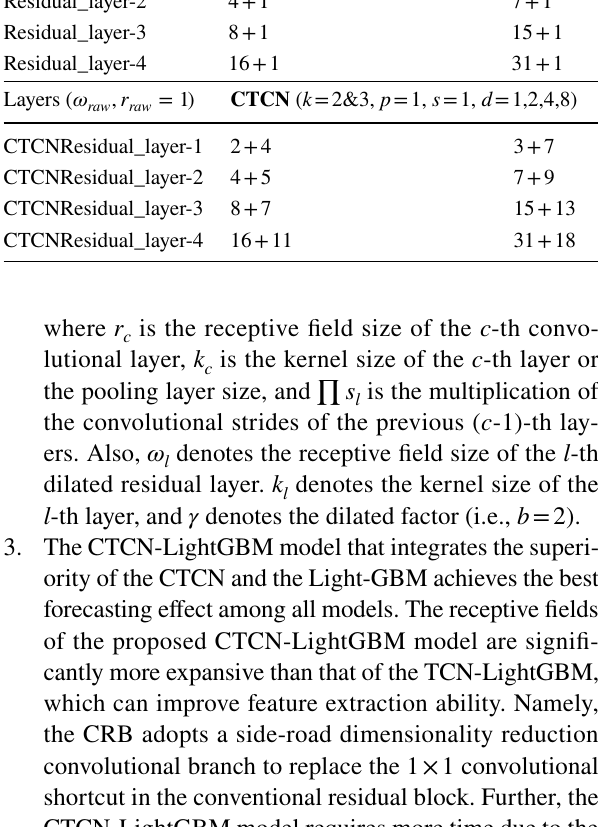
Table 18 Comparison of the model’s time complexity